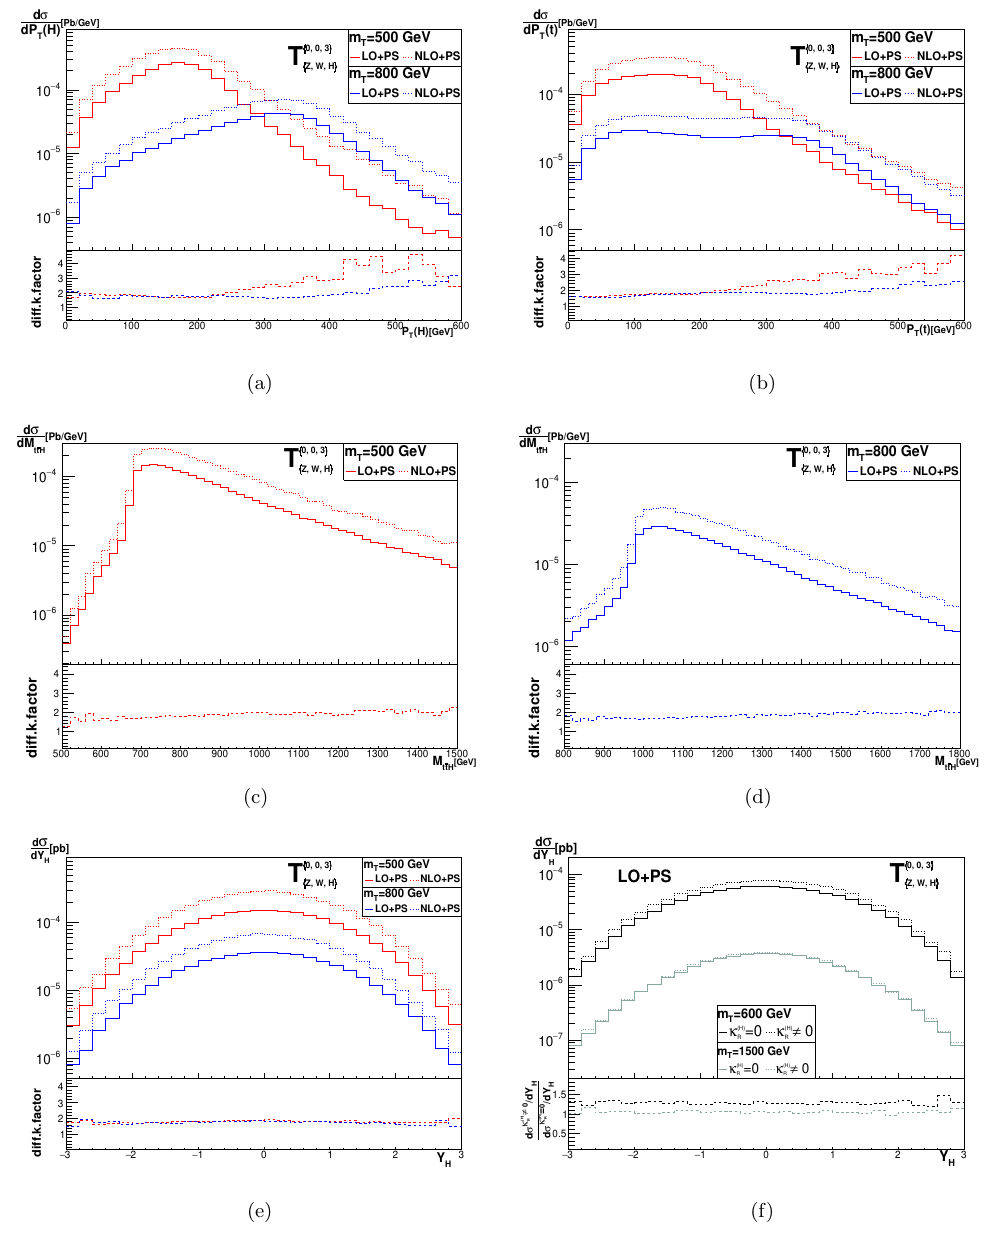
Figure 8 . Di(cid:11)erential distributions of some observables for the t (cid:22) tH (cid:12)nal state in the benchmark scenario T f 0 ; 0 ; 3 g , for di(cid:11)erent m values, at leading and next-to-leading orders matched to parton T f Z ; W ; H g